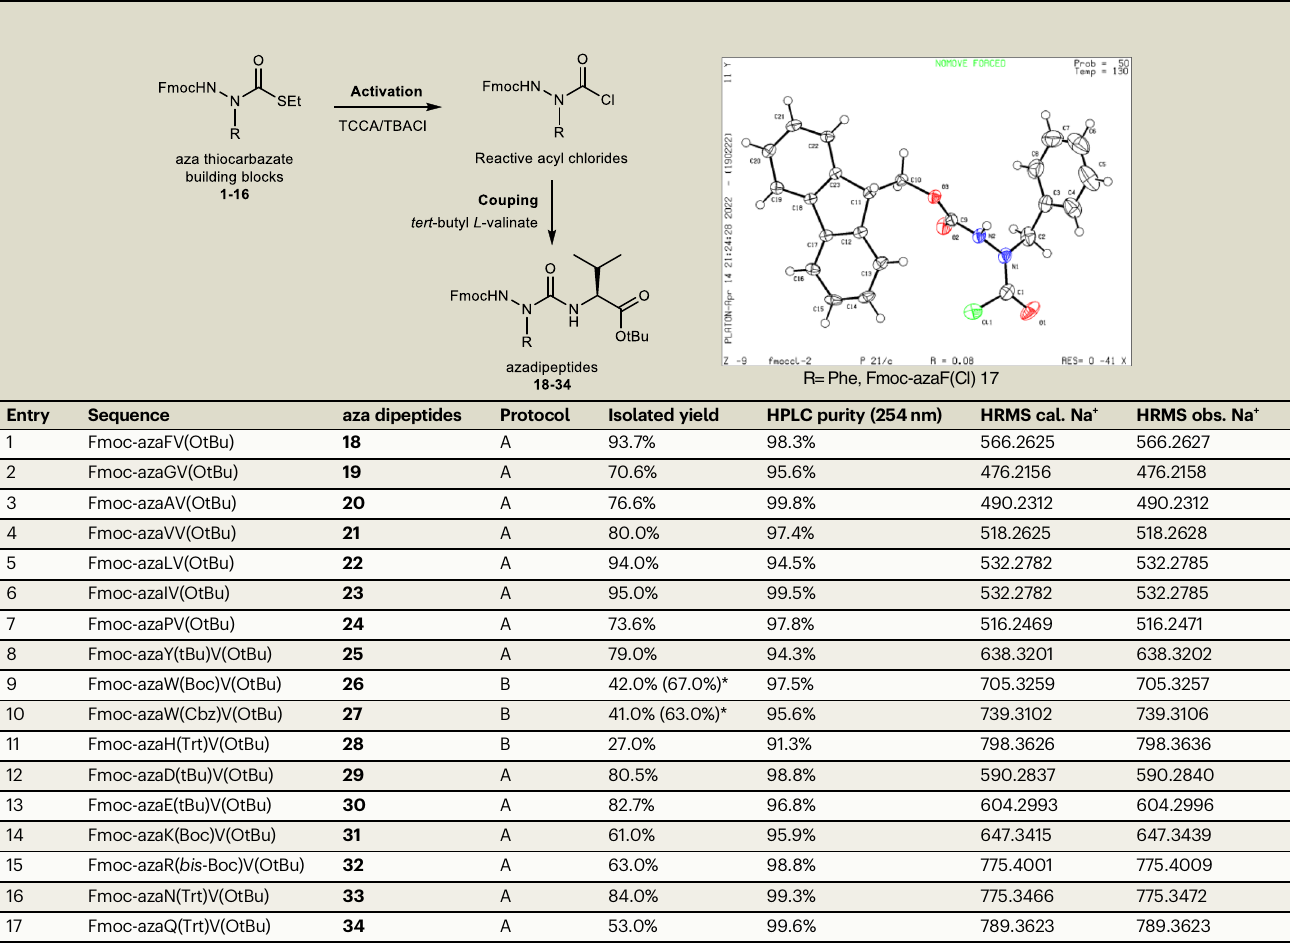
Table 1 | General and modi fi ed protocols for thiocarbazates activation and coupling in solution-phase